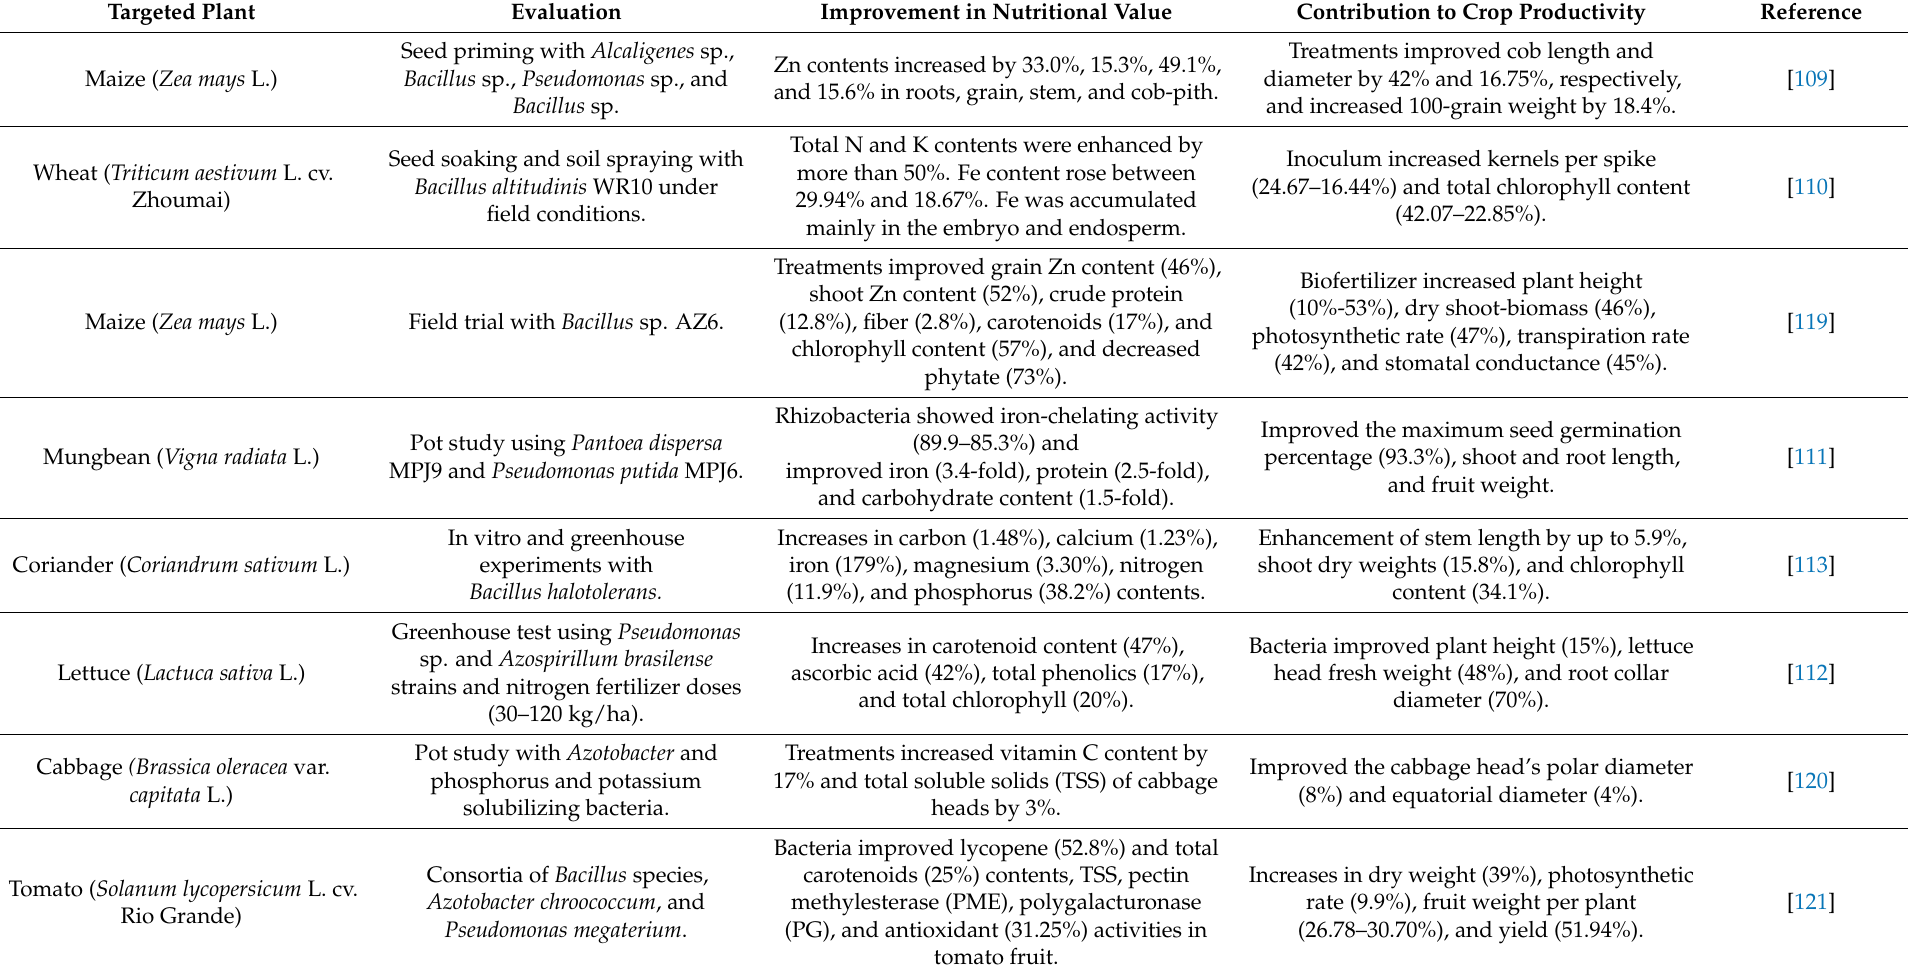
Table 2. Studies of micronutrient biofortification using beneficial soil